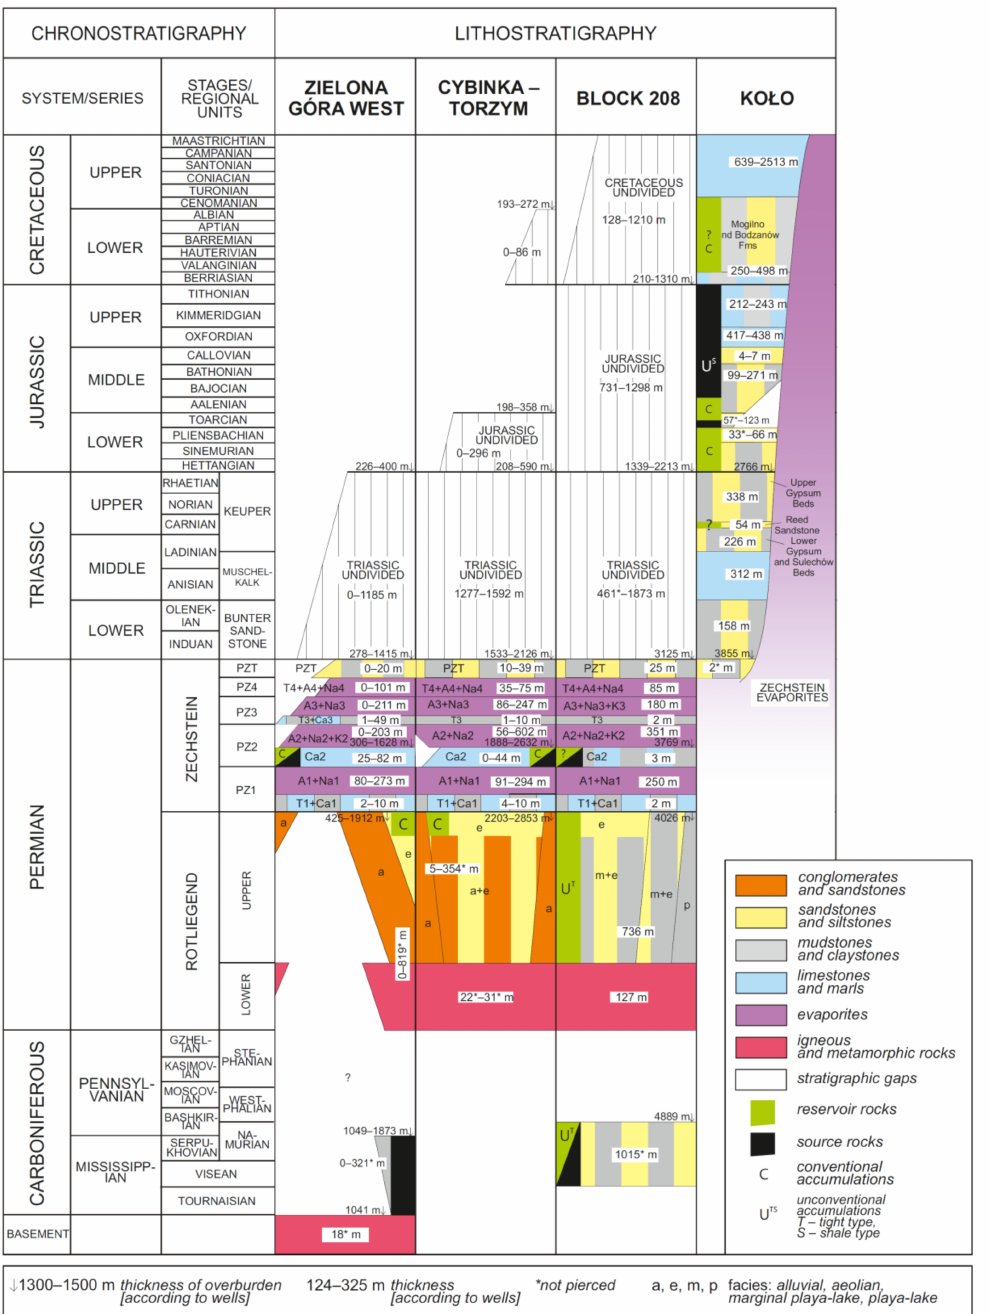
Figure 8. Stratigraphy, lithology, and petroleum system elements (horizons of source and reservoir rocks) in Block 208, Cybinka–Torzym, Zielona G ó ra West, and Koło tender area dedicated to the 6th tender round for hydrocarbon concessions in